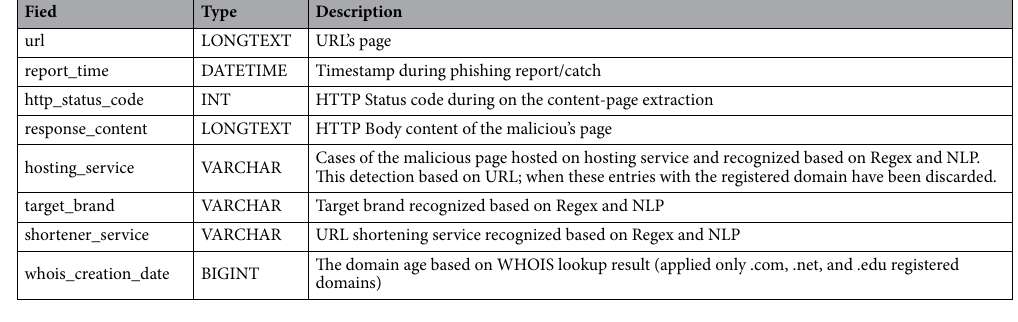
Table 10. Entries structure details.